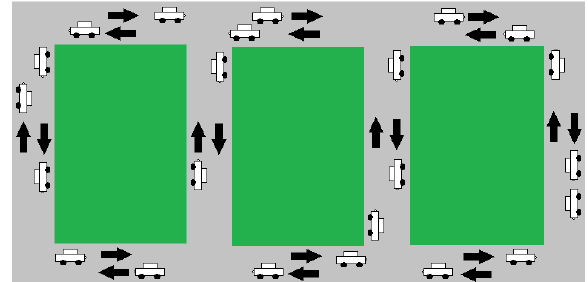
Figure 3. An Example of a Manhattan Grid Topology with Double-Way Roads